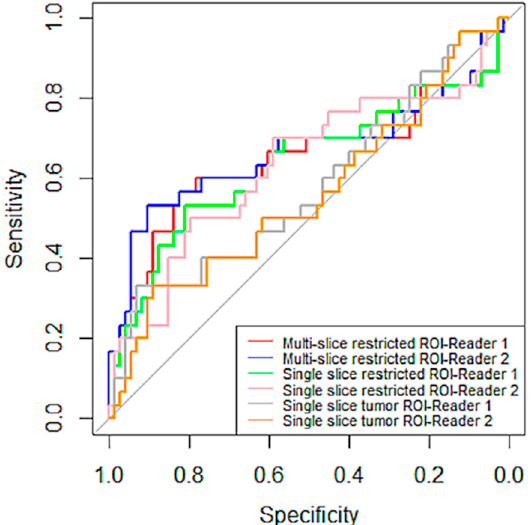
Figure 6. ROC curves of percentage change in mean tumor ADC by reader and ROI type. ROI curves for multiple-scheme 1. and blue (Reader 2). The curves in green and pink are for single-slice restricted ROI by Reader 1 and Reader 2, respectively. The last two pairs are curves in gray and tan, representing ROC curves for single-slice tumor ROI by Reader 1 and Reader 2, respectively. The gray straight diagonal line represents AUC =